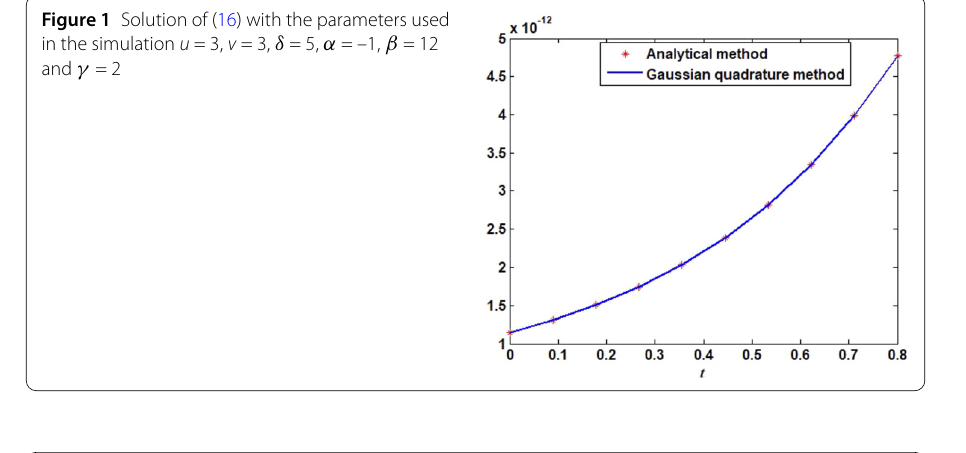
Figure 2 Solution of (19) with the parameters used in the simulation u = 6, v = 3, δ = 5, α = –1, β = 12 and γ =